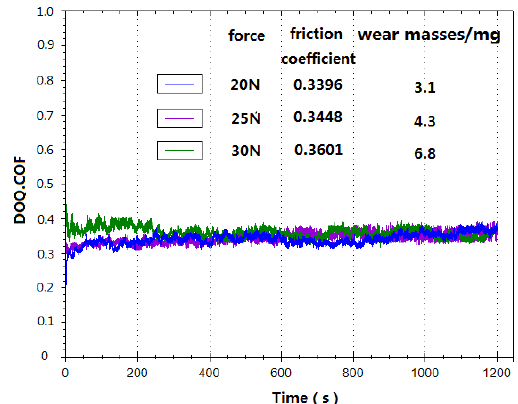
Figure 8. The friction coefficient curve of the Zn-Al-Mg-TiO 2 coating.